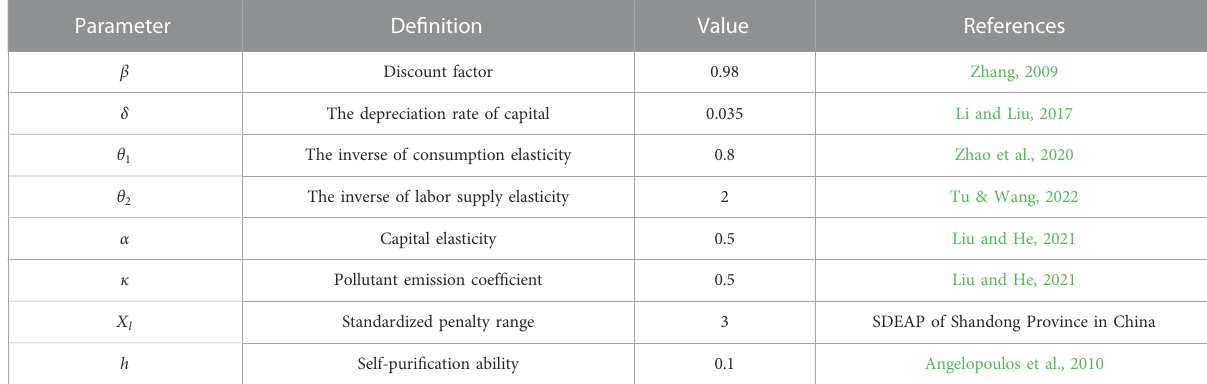
TABLE 6 Values of equilibrium solution parameters.